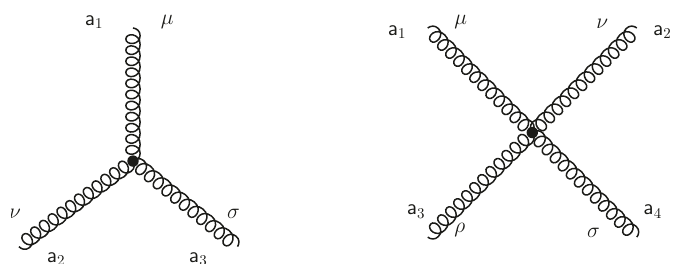
Figure 2 . The three- and four-point gluon